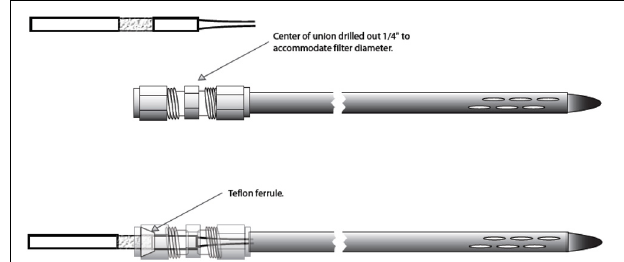
FIGURE 1 | Representation of soil probe design used to sample volatiles belowground. Probe is inserted into soil and connected to a vacuum pump. Reprint from “Extending explorations of belowground herbivore-induced plant volatiles: attracting natural enemies of root pests in multiple contexts (Ali et al.,